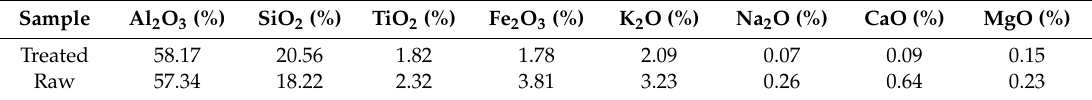
Table 1. The X-ray fluorescence (XRF) results of bauxite samples, presented as